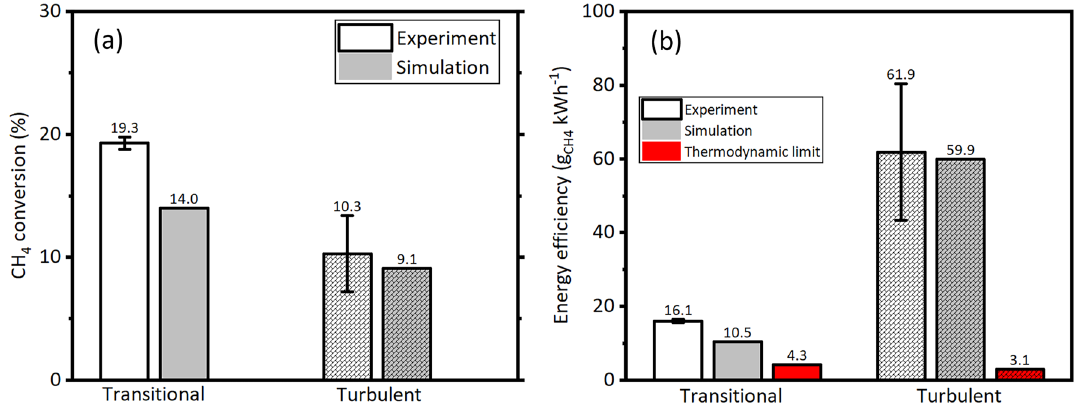
Figure 6. CH 4 conversion ( a ) and its energy efficiency, ( b ) at transitional, and turbulent flow regimes; estimated from experiment, simulation and thermodynamic equilibrium analysis.